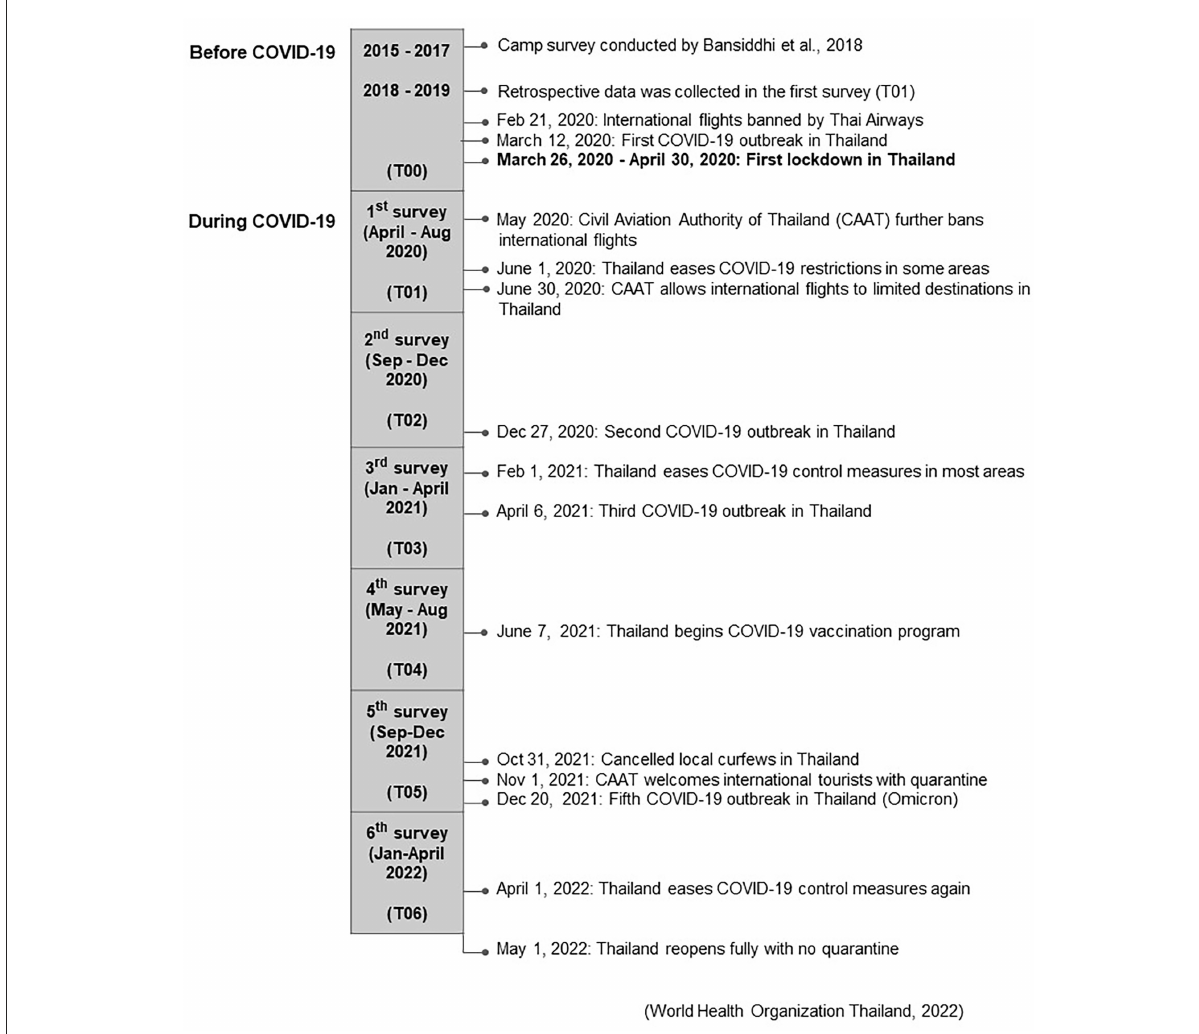
FIGURE2 Associated events before the COVID-19 pandemic (T00), and across the six survey periods (T01-T06) during the study.